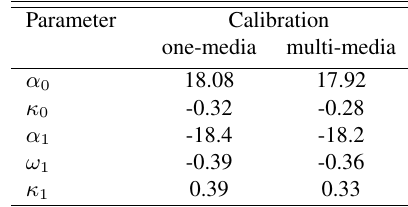
Figure 5. A calibration image of test field in a liquid